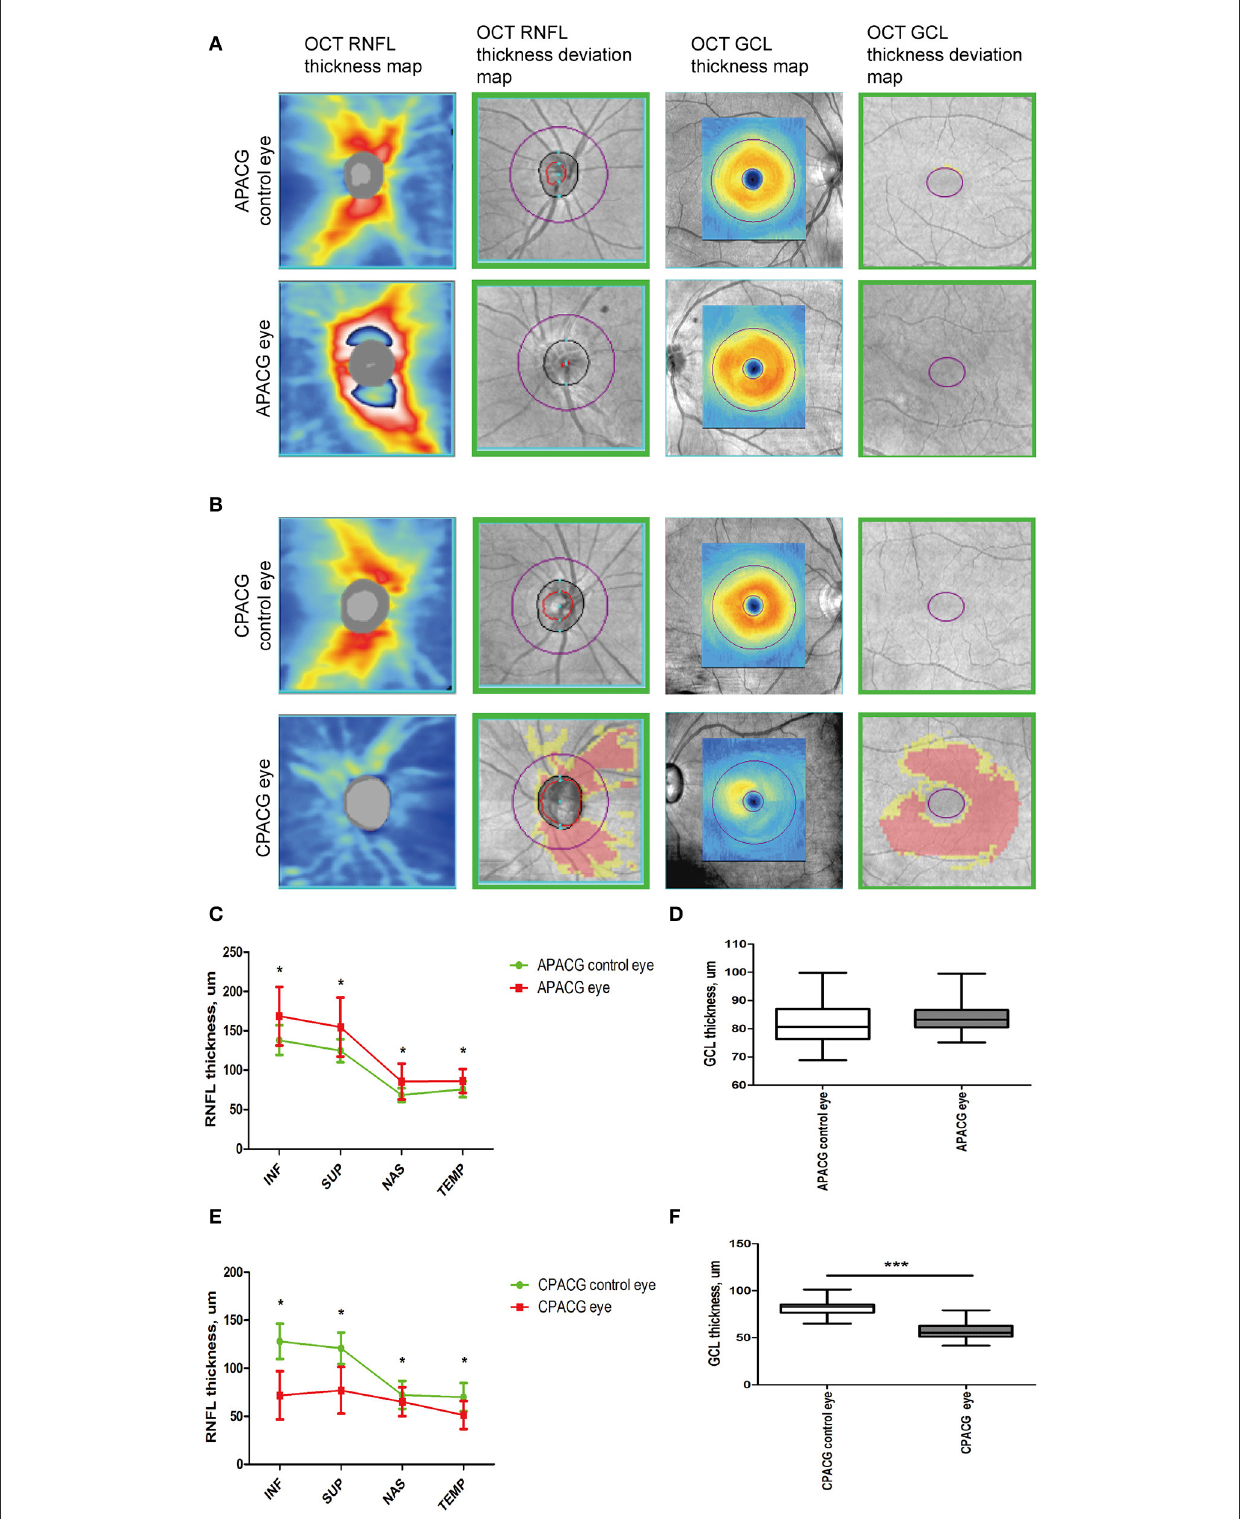
FIGURE1 Heterogeneity such as RGC axon and soma presenting edema insulted by acute damage but atrophy in chronic glaucoma evaluated by OCT. (A) OCT RNFL thickness maps, OCT RNFL thickness deviation maps, OCT GCL thickness maps, and OCT GCL thickness deviation maps are presented, which show that the thickness of RNFL and GCL increased significantly after an acute attack. The warm colors on the thickness maps represent a thicker RNFL or GCL and cooler colors represent a thinner one. (B) OCT imaging showed an obvious loss of RNFL and GCL loss insulted by chronic damage in CPACG. The cooler colors in thickness maps suggested RNFL and GCL thickness reduction. Areas coded in red and yellow in deviation